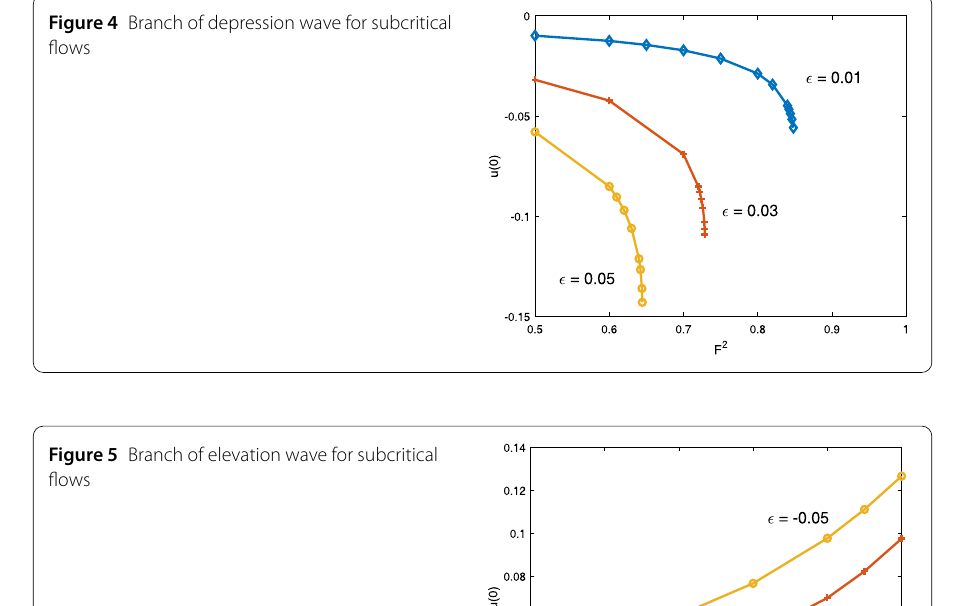
Figure 4 Branch of depression wave for subcritical flows